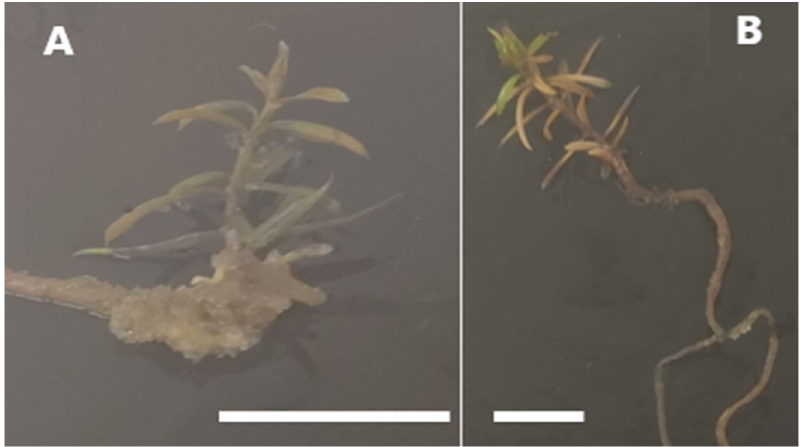
Figure 8. Seedlings inoculated by the liquid co-culture in vitro method after 28 days of inoculation. ( A ) Inoculated seedling. ( B ) Control seedling. Bars = 1.0 cm. ( A ) Inoculated seedling. ( B ) Control seedling. Bars = 1.0